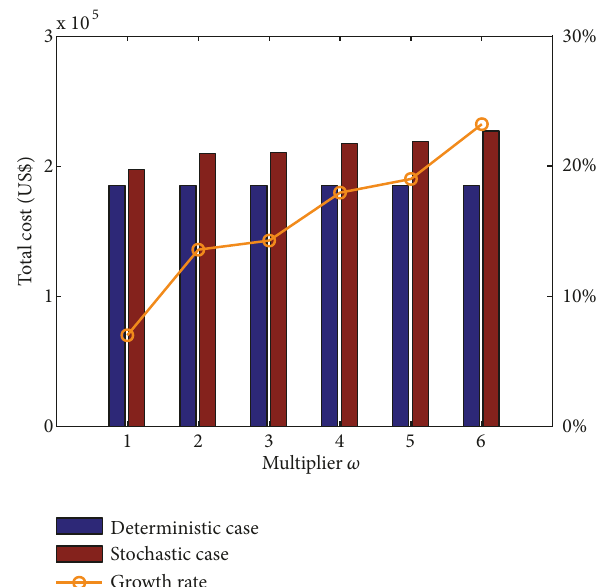
Figure 7: The total costs under different multiplier 𝜔 .